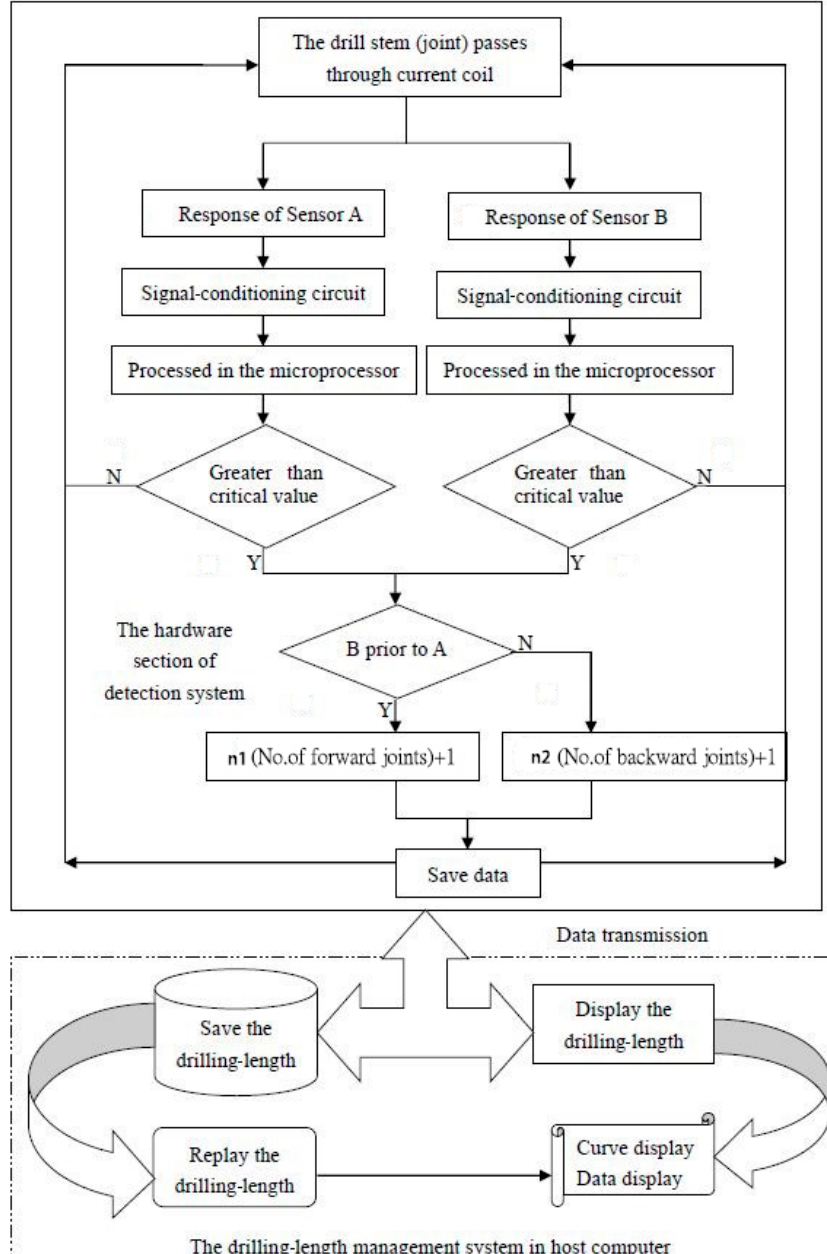
Figure 5. Flow chart of contactless detection.